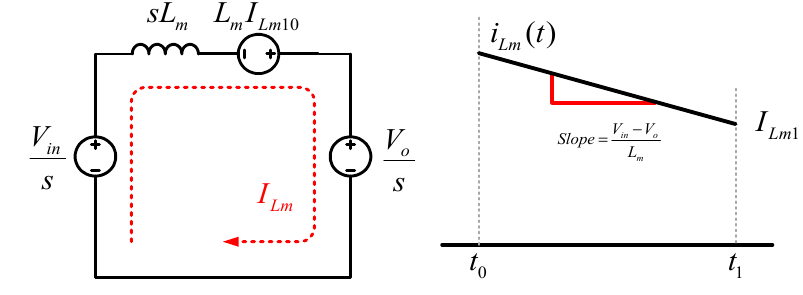
Figure 4. Equivalent circuit of Mode 1 and key waveform.